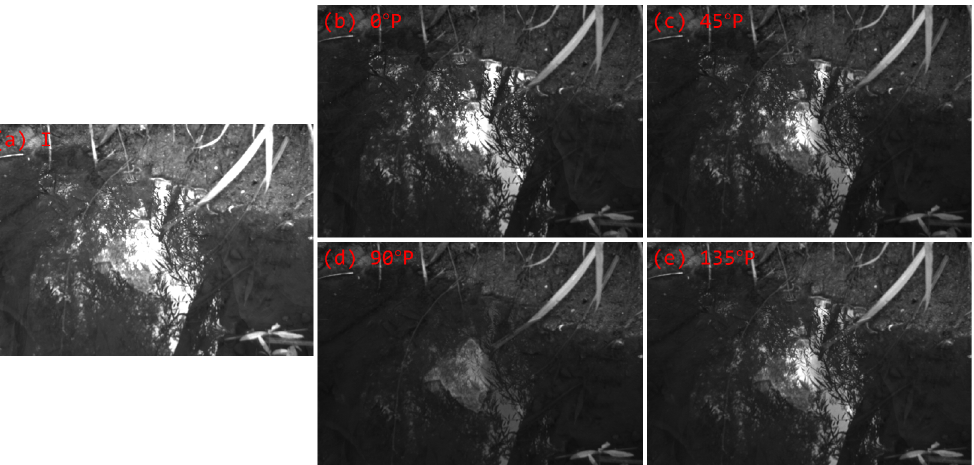
Figure 4. Case Ⅲ : coastal topography mapping